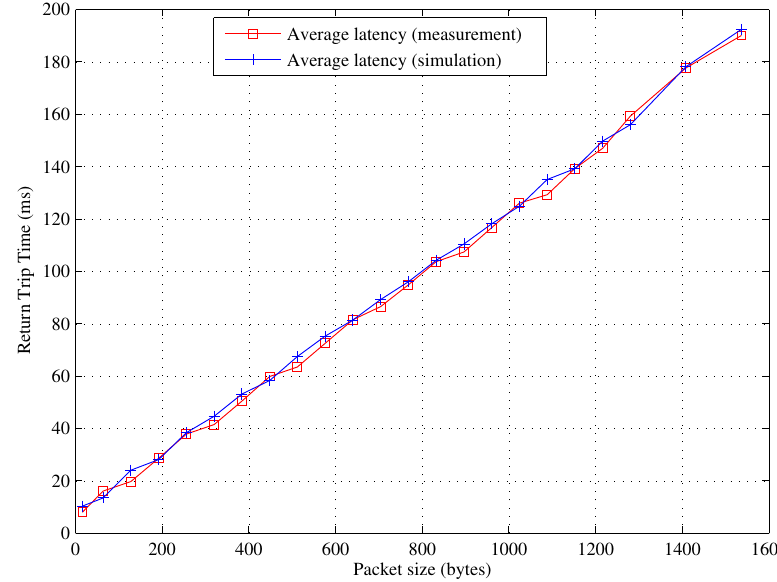
Figure 7. Model validation by comparing Return Trip Time (RTT) from simulation with measurement.